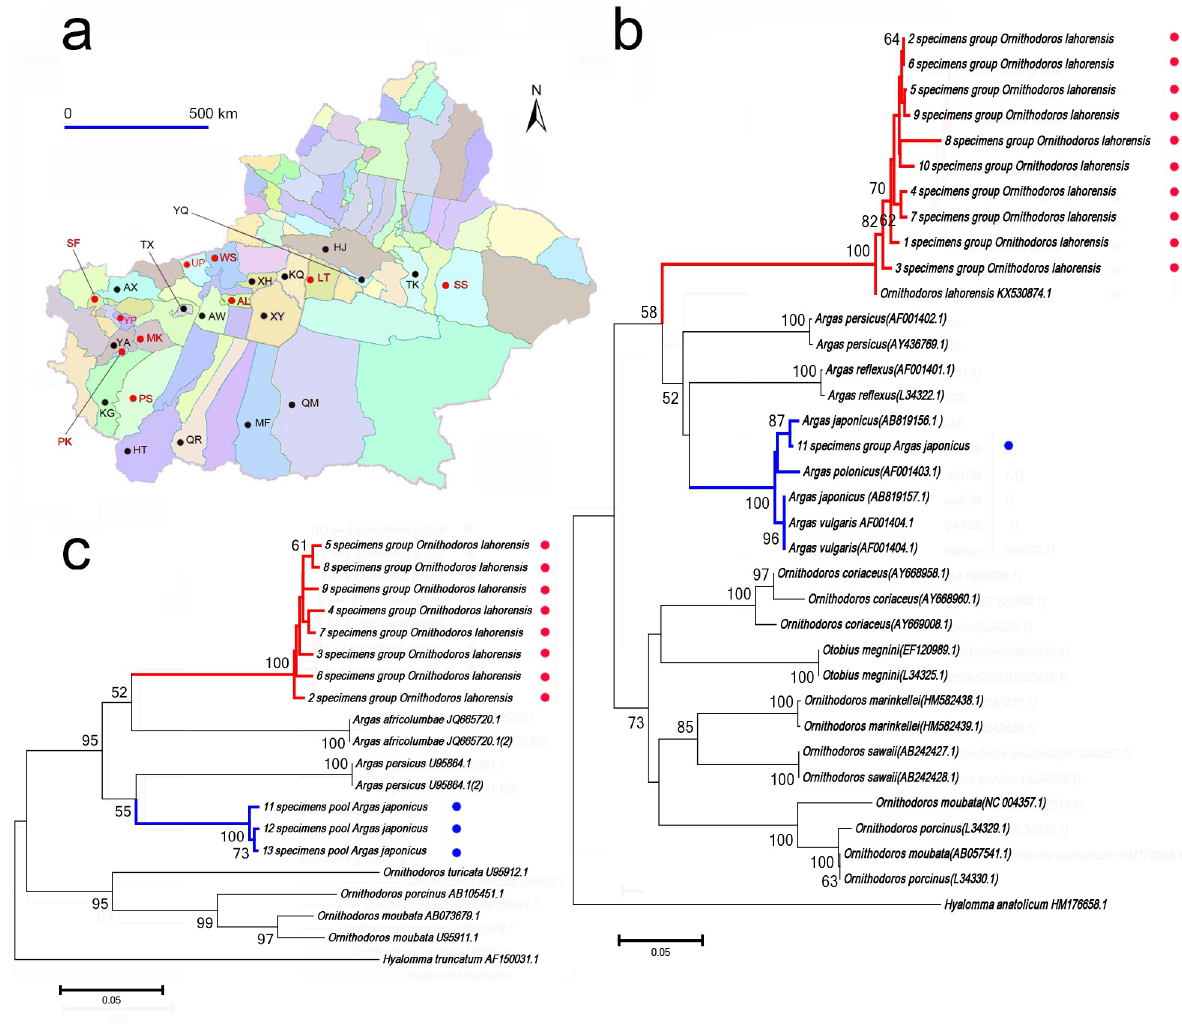
Fig 1. A map of Xinjiang Province and phylogenetic analyses of tick species based on 12S rRNA and 16S rRNA. A. argasid ticks were surveyed in 25 counties in southern Xinjiang. Argasid ticks were collected from 10 counties which are marked with red dots, while other 15 counties are marked with black dots, B. Neighbour joining phylogenetic analysis based on partial 16S rRNA sequences of ticks, C. Neighbour joining phylogenetic analysis based on partial 12S rRNA sequences of ticks. Bootstrap values are indicated at the nodes. Scale bar indicates the degree of divergence represented by a given length of branch. The red and blue dots indicate the DNA sequences of tick specimens acquired in this study. Abbreviations : AL, Aral; AX, Artux; AW, Awat; HJ, Hejing; HT, Hetan; KG, kargilik; KQ, Kuqa; LT, Luntai; MK, Makit; MF, Minfeng; PS, Pishan; PK, Poskam; QM, Qiemo; QR, Qira; SS, ShanShan; SF, Shufu; TX, Tumxuk; TK, Tuokexun; UP, Uqturpan; WS, Wensu; XY, Xayar; YP, Yopurga; XH, Xinhe; YQ, Yanqi; YA,